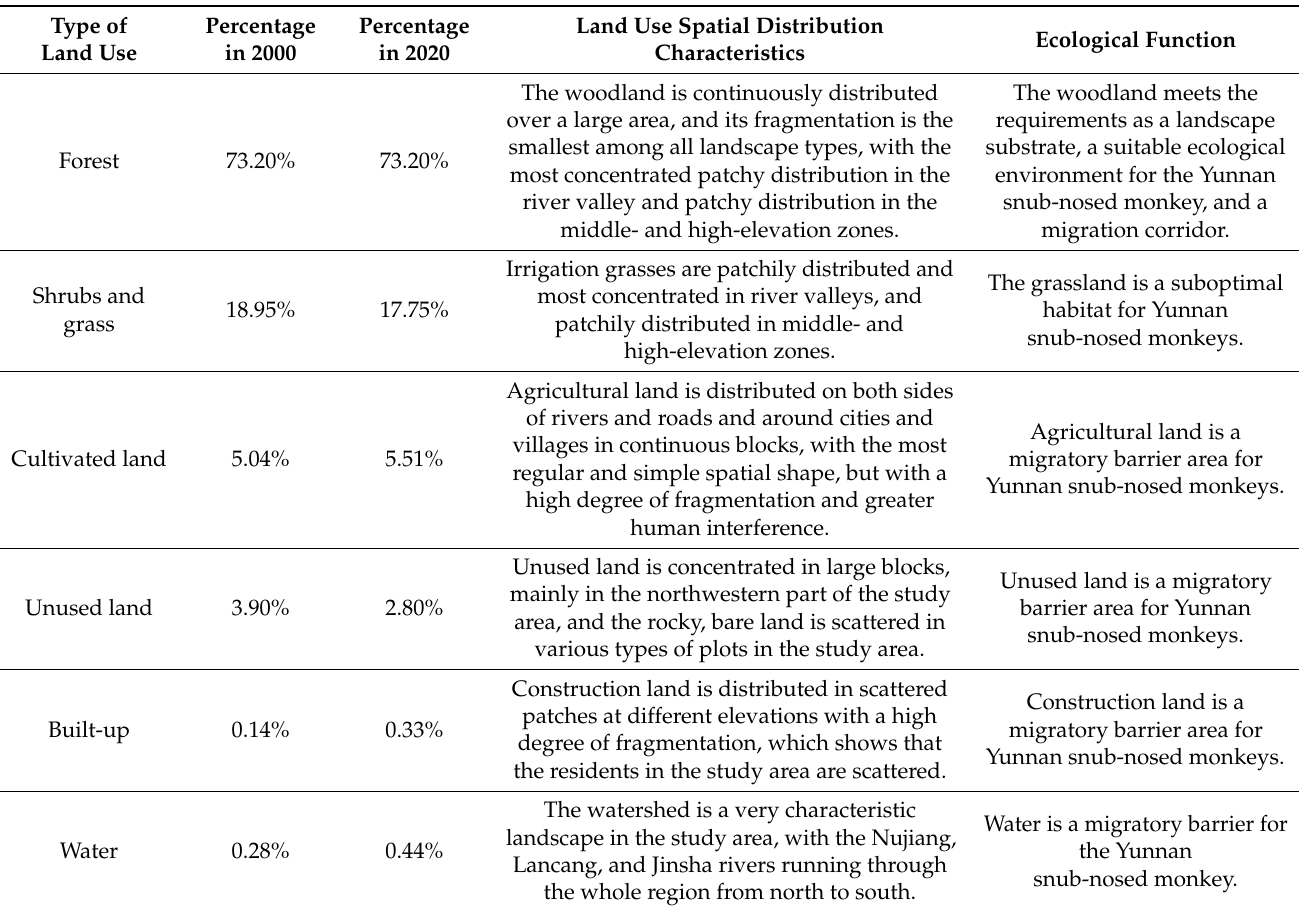
Table 2. Analysis of land use characteristics and ecological functions in the study area